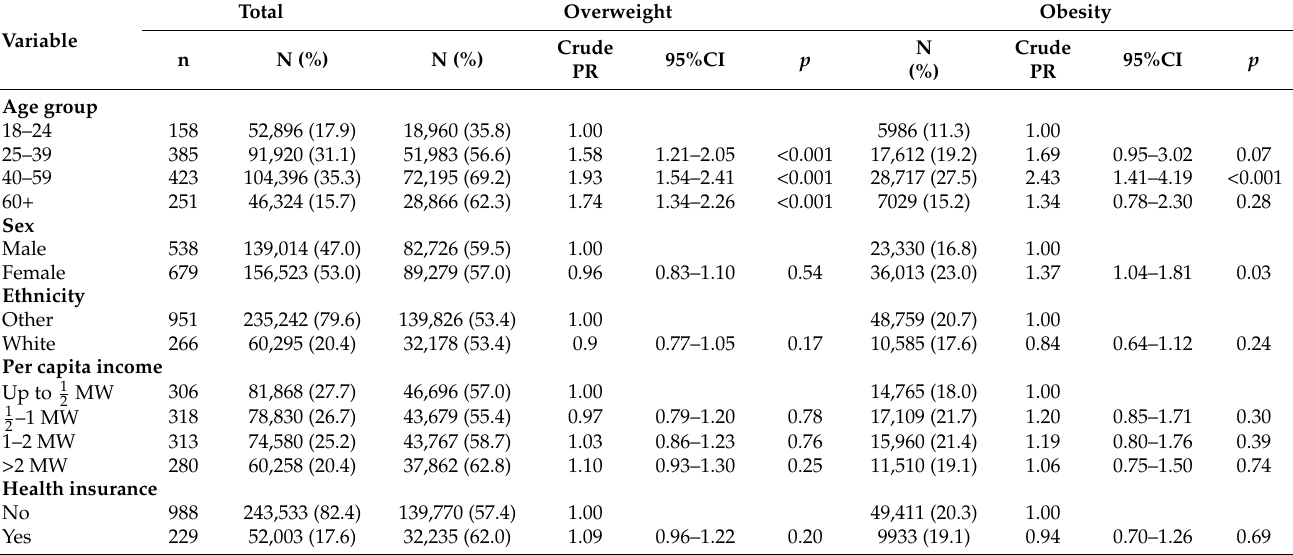
Table 1. Prevalence of overweight and obesity in adults in Rio Branco, Acre, 2019, according to sociodemographic and economic